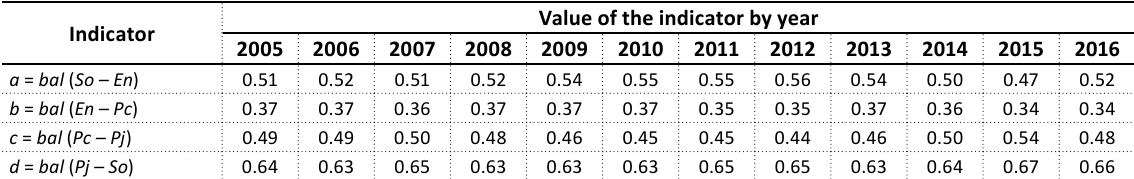
Table 4. Indicators of mutual balance of enterprise subsystems for the 2005–2016 period (generalized by the group of enterprises)